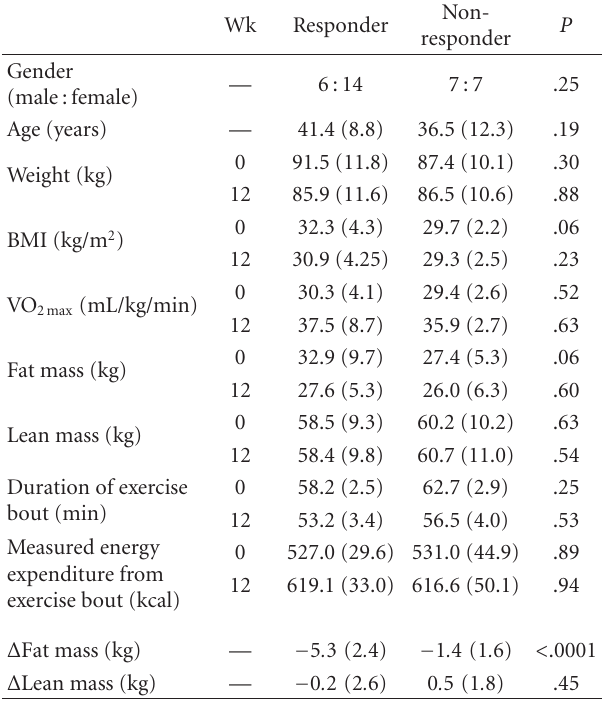
Table 2: Participant characteristics and changes after medium-term exercise intervention for responders and